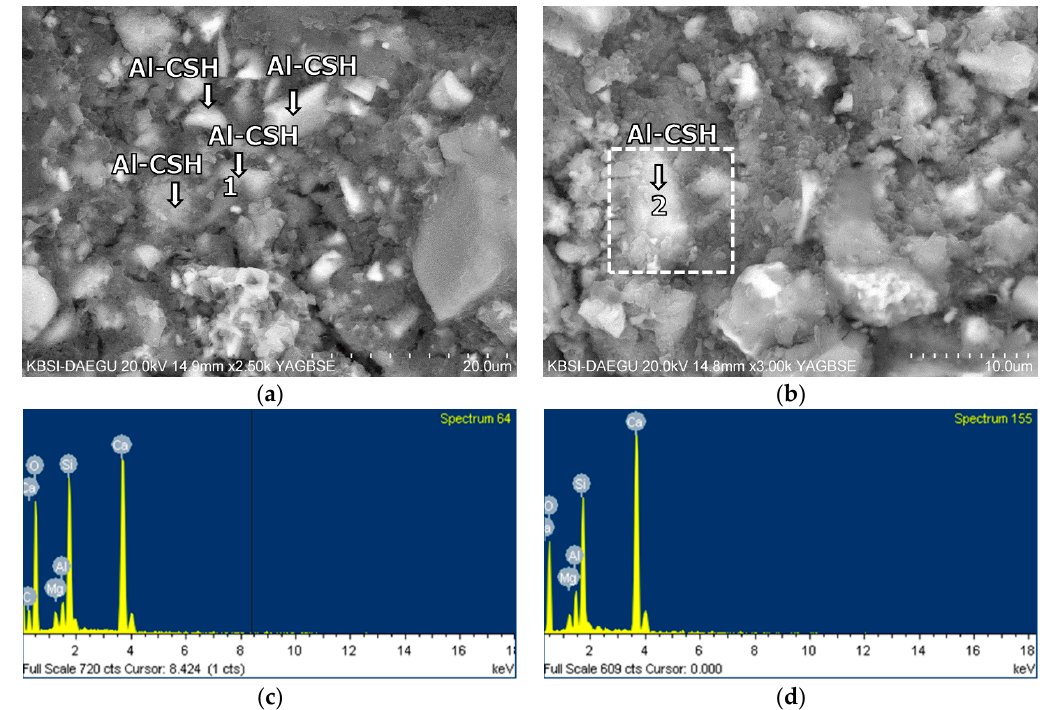
Figure 15. The microstructures of mixture B-10-Y at 28 days: BSE images magnified by ( a ) ×2500; and ( b ) ×3000; EDS spectrum of ( c ) point 1 in ( a ); and ( d ) point 2 in ( b ).